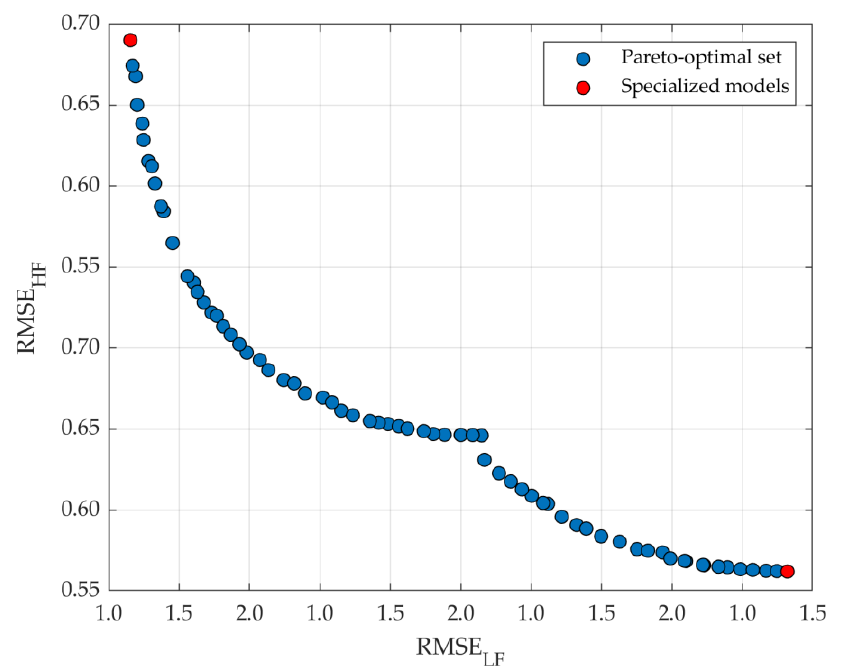
Figure 6. Pareto-optimal solutions in the objective space (blue) and specialized models (red).